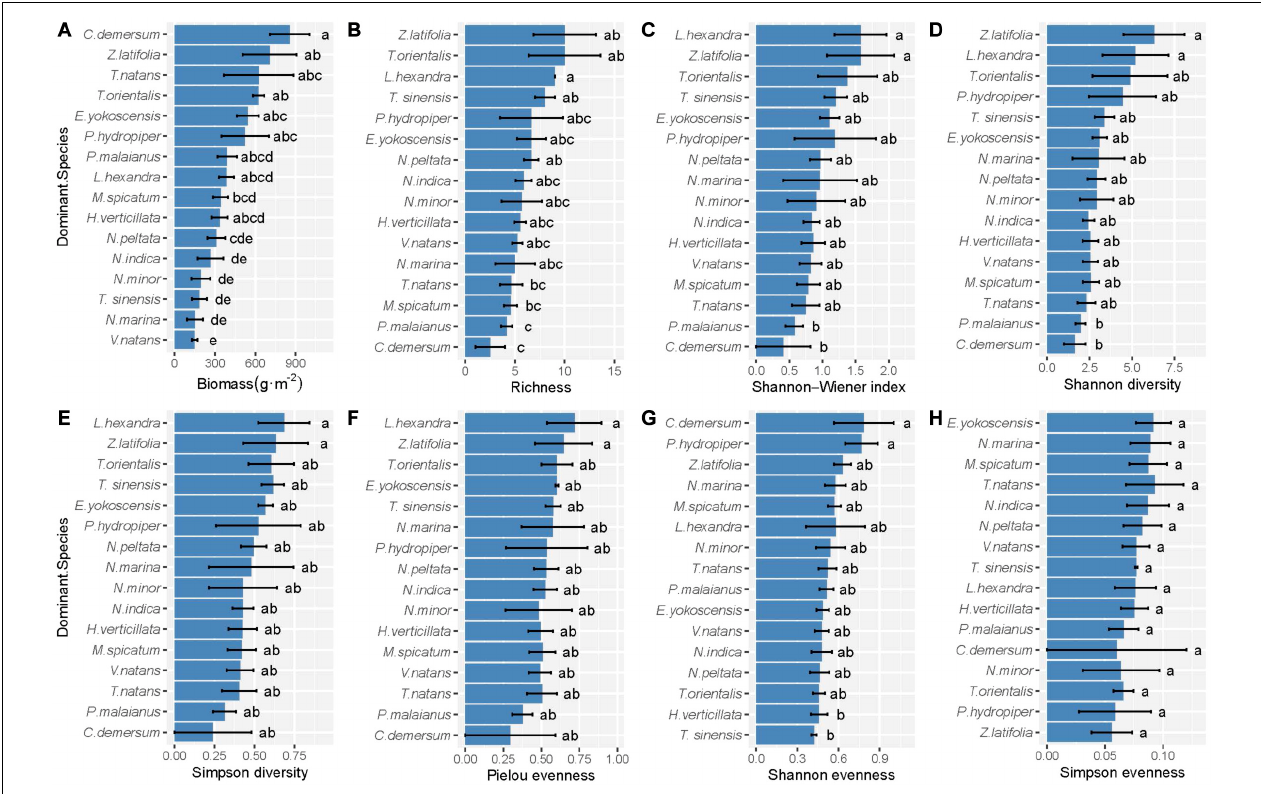
FIGURE 3 | The difference of (A) productivity, (B) richness, (C) Shannon–Wiener index, (D) Shannon diversity, (E) Simpson diversity, (F) Pielou evenness, (G) Shannon evenness, and (H) Simpson evenness of the community with different dominant species. Error bars indicate standard error. Within each panel, bars labeled with different letters are significantly different according to Tukey tests ( P <